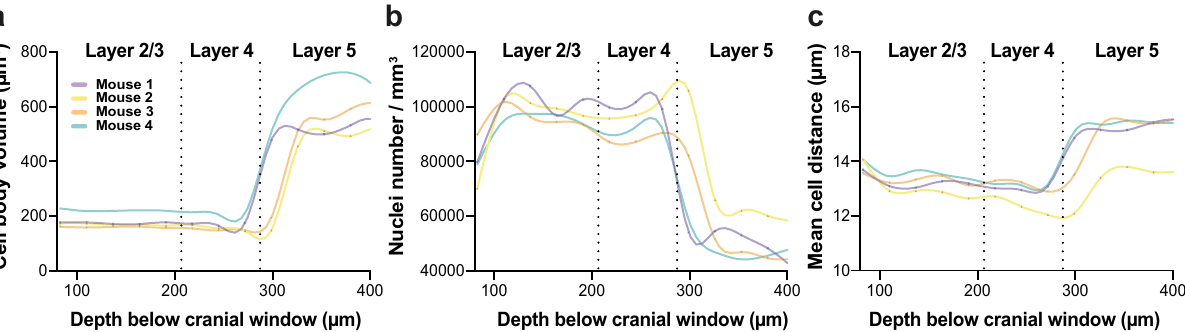
Figure 3. Quantifying cellular morphological features across the cortical column of mice in vivo. Four male mice were imaged by our OCT neuroimaging system and morphological traits were assessed and quantified: ( a ) average CNS cell body volume ( b ) average CNS cell body density ( c ) average distance to the nearest neighboring CNS cell